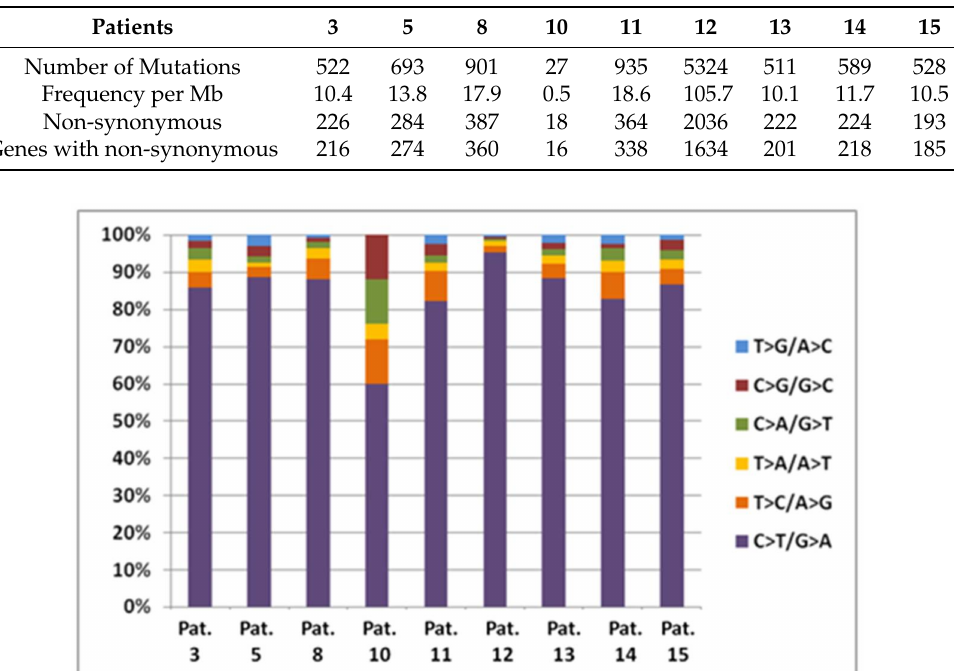
Figure 1. Mutation spectrum for each patient. C > T transitions account for 85.6% of the mutations (median